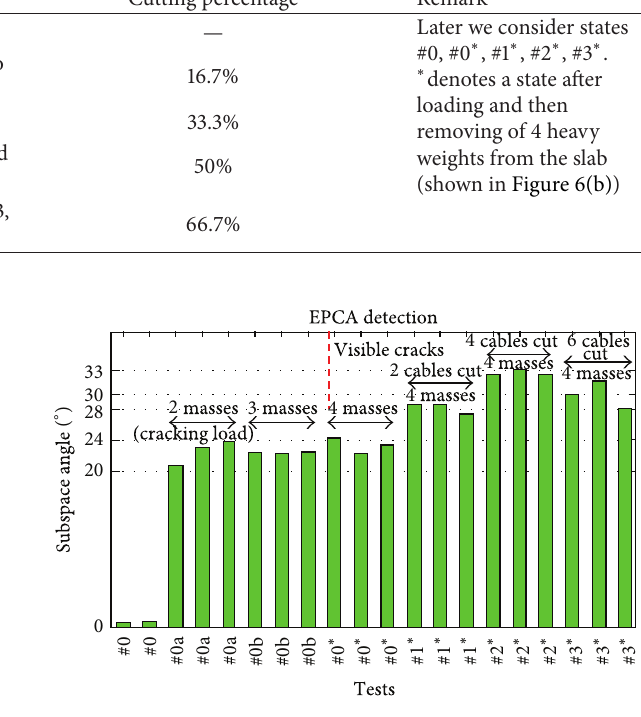
Figure 8: EPCA detection for the RC slab (always unloaded